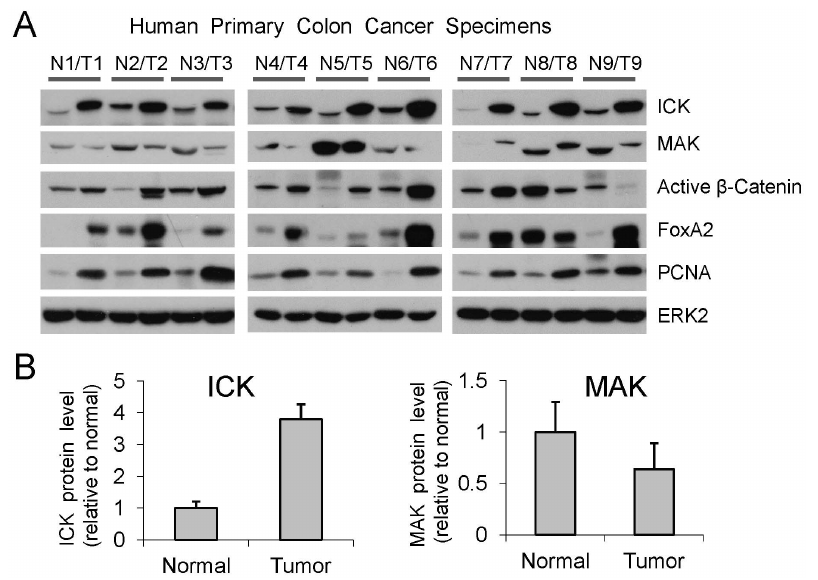
Figure 6. ICK and MAK proteins exhibited distinct expression patterns in human colorectal tumors. (A) Tissue extracts from nine pairs of human specimens macro-dissected from primary colon tumor (T) and its surrounding normal mucosa (N) were prepared. Equal amount of total proteins (30 m g) from tissue extracts were loaded for Western blot. ERK2 signals indicate equal loading of total proteins. PCNA was used as a proliferation marker. (B) Western blot signals of ICK and MAK were quantified by densitometry and normalized against ERK2 signals. ICK and MAK protein levels in tumors relative to their adjacent normal tissues were shown as mean 6 SE, n=9, P , 0.05, Paired t -Test.